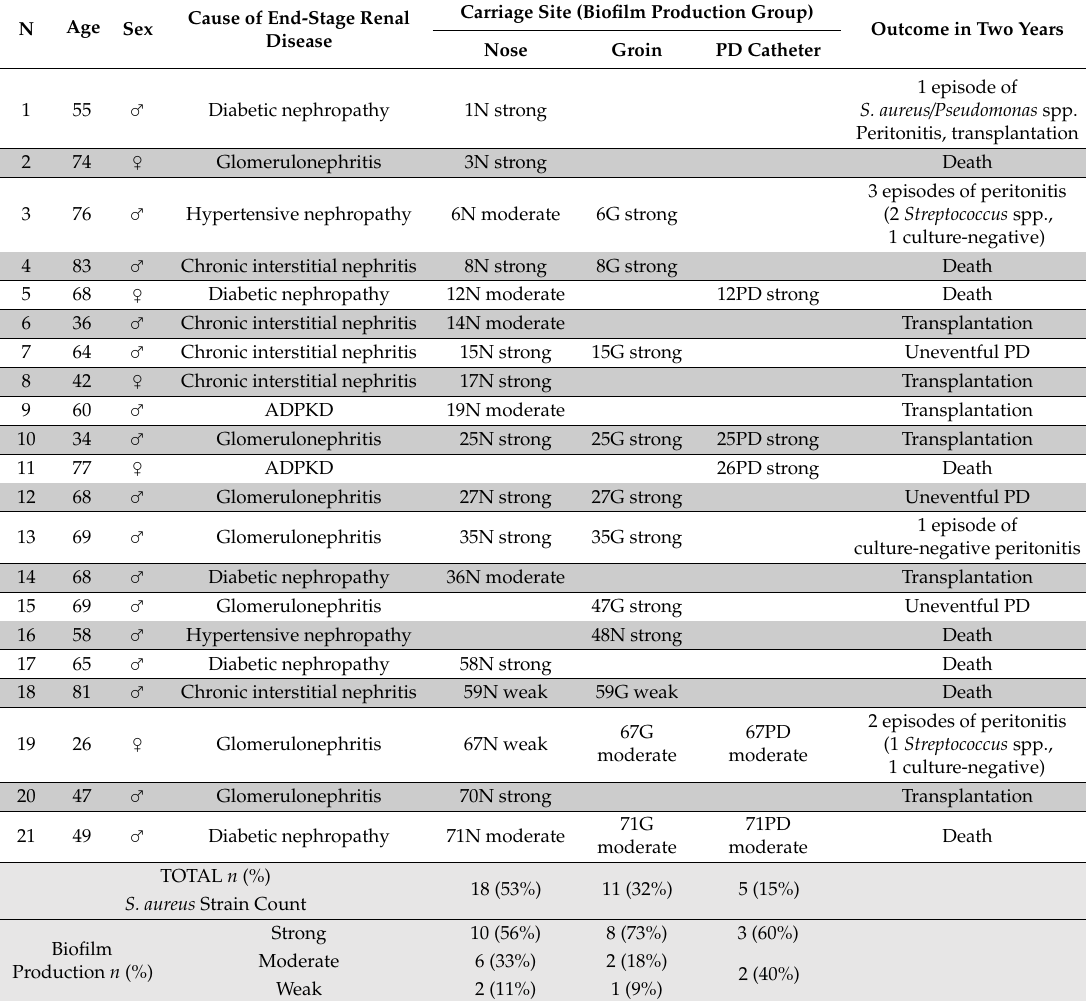
Table 1. S. aureus carrier characteristics. Note: PD, peritoneal dialysis; ADPKD, autosomal dominant polycystic kidney disease.